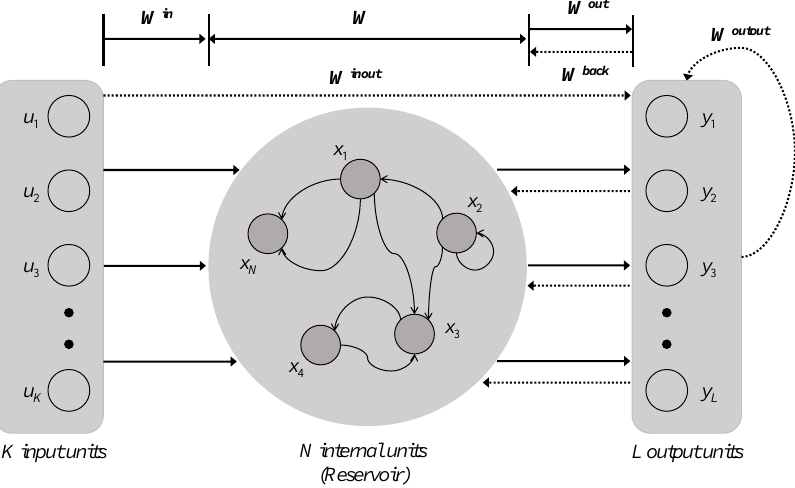
Figure 1. An Echo State Network. Solid arrows: fixed weights; dashed arrows: trainable weights. Adapted from Ferreira, Ludermir and Aquino